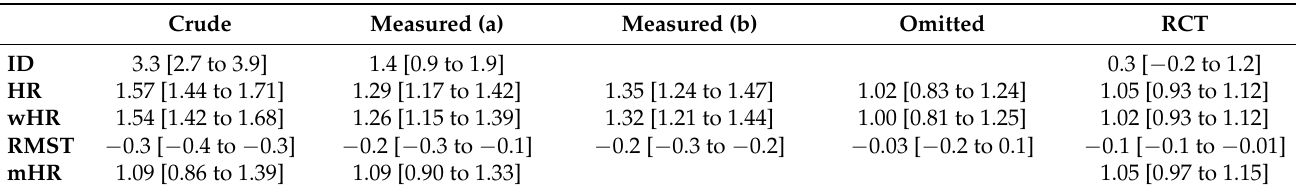
Table 1. Summary. Punctual and 95% confidence intervals for some of measured reported along the paper: incidence difference (ID), conditional hazard ratio (HR), weighted hazard ratios (wHR), restricted mean survival times at twelve months (RMST), and marginal hazard ratios (mHR) in the different considered situations: unadjusted models (Crude), match-sample (Measured (a)), models adjusted by measured confounders (Measured (b)), models adjusting by both measured and no measured confounders (Omitted), and results provided by the